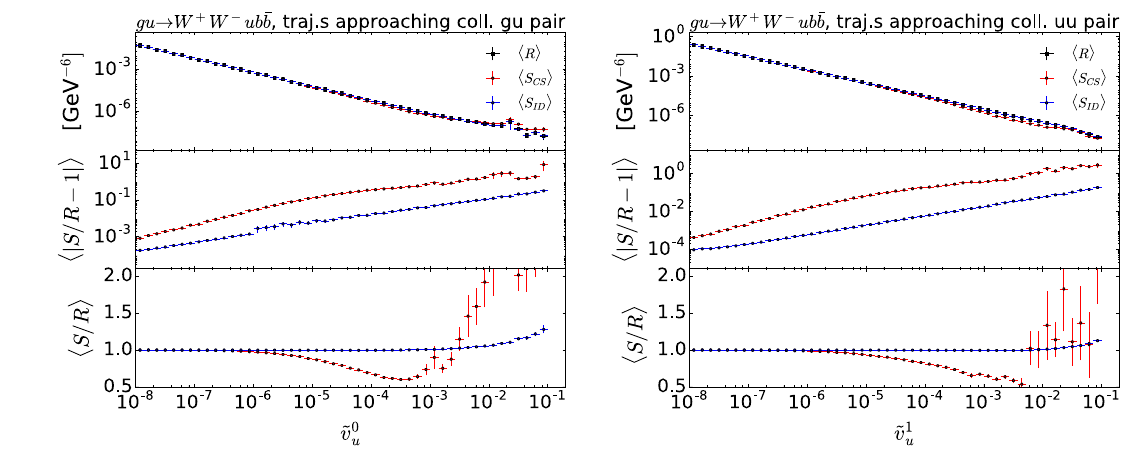
the text. Left: the u -quark in the final state becomes collinear to the first initial-state parton. Right: the u -quark in the final state becomes collinear to the second initial-state parton